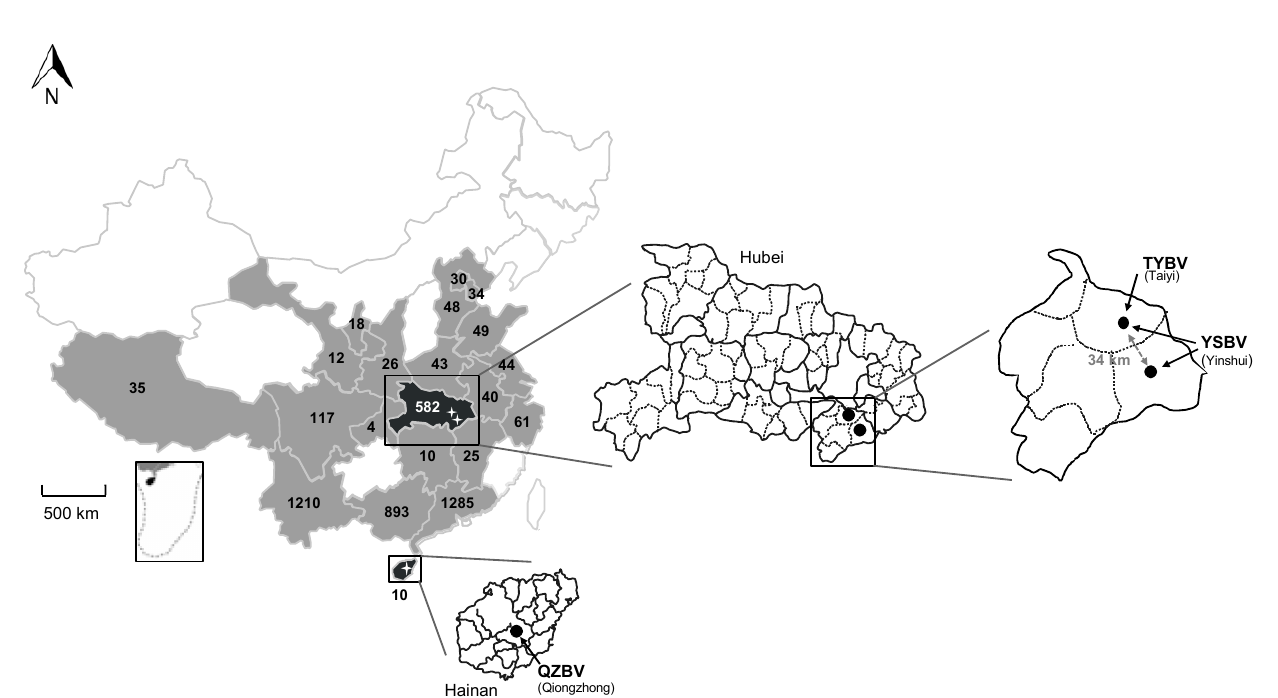
Figure 1. Repartition of the bat samples analyzed in this study and collected in 21 provinces of China (in grey and back) during the period 2006–2018, with the total number of samples indicated per province. The two provinces in black (Hainan and Hubei) indicate the presence of positive samples. Magnifications of these provinces are presented, with the position and the name of the positive sample caves or sites indicated with black dots, as well as the different rhabdovirus identified (TYBV: Taiyi bat virus, YSBV: Yinshui bat virus, and QZBV: Qiongzhong bat virus). Table 1. Distribution of the different bat families tested in this study, according to the type of sample. Bat Family